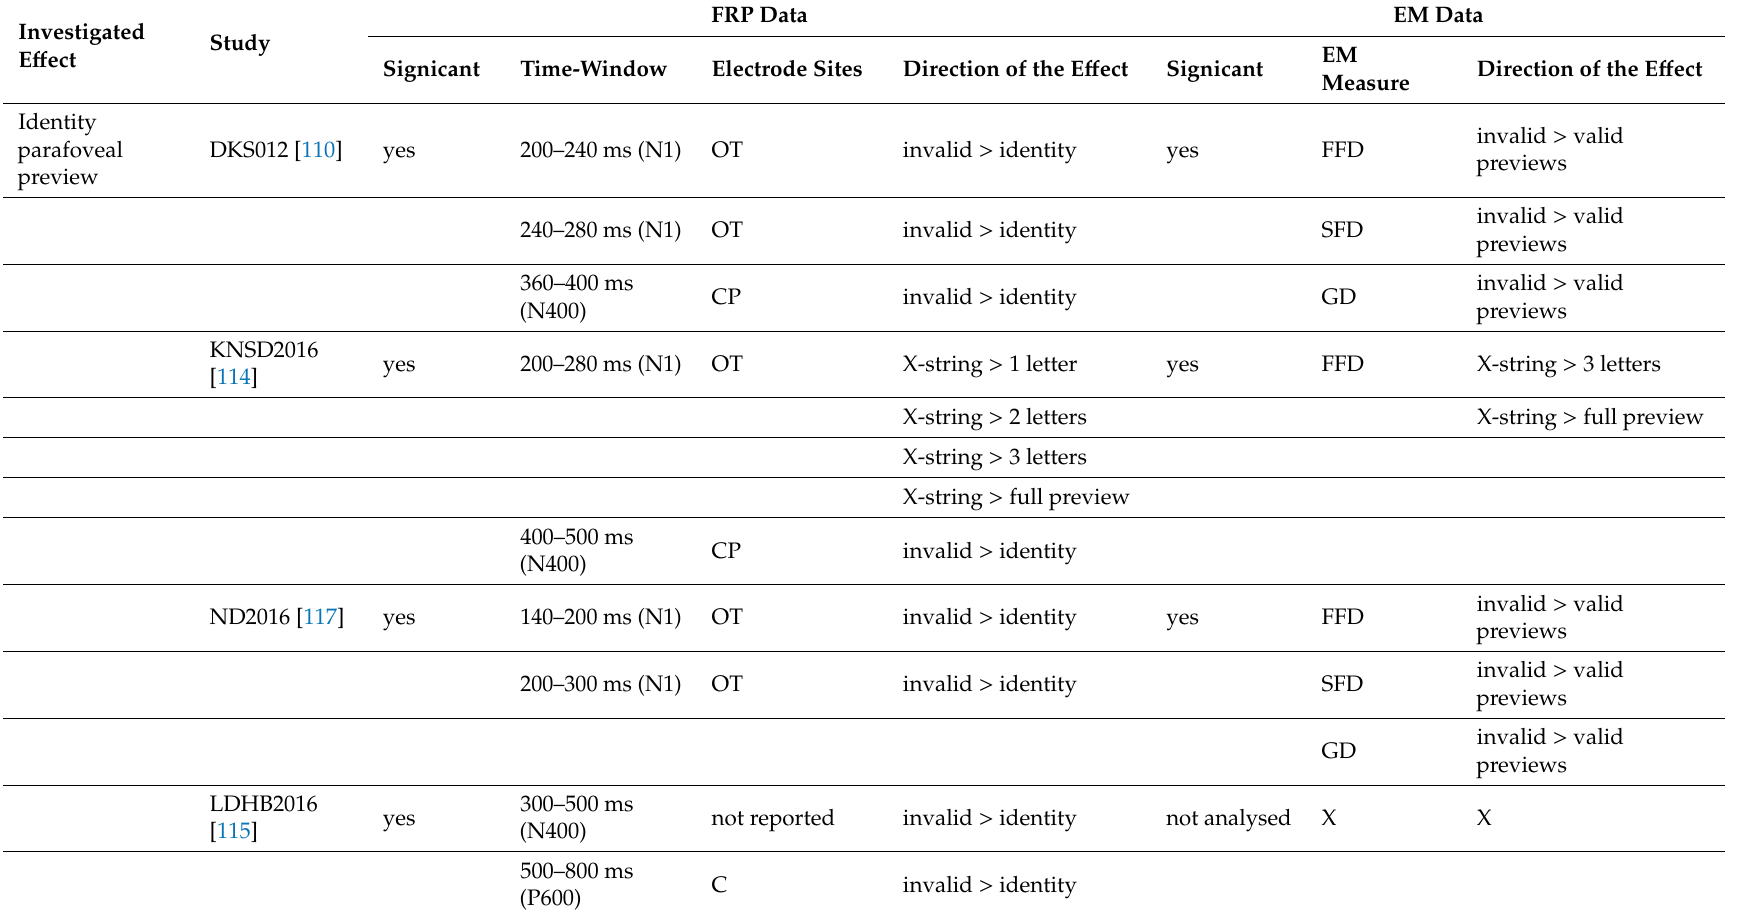
Table 3. Summary of the Findings Reported in Co-Registration Studies Investigating Preview E ff ects. In these studies, the e ff ects associated with parafoveal manipulation were measured when both EMs and FRPs were time-locked to the initial fixation onset on the target word, to examine the influence that the pre-processing of an upcoming word in the parafovea exerts on the processing of that word when currently